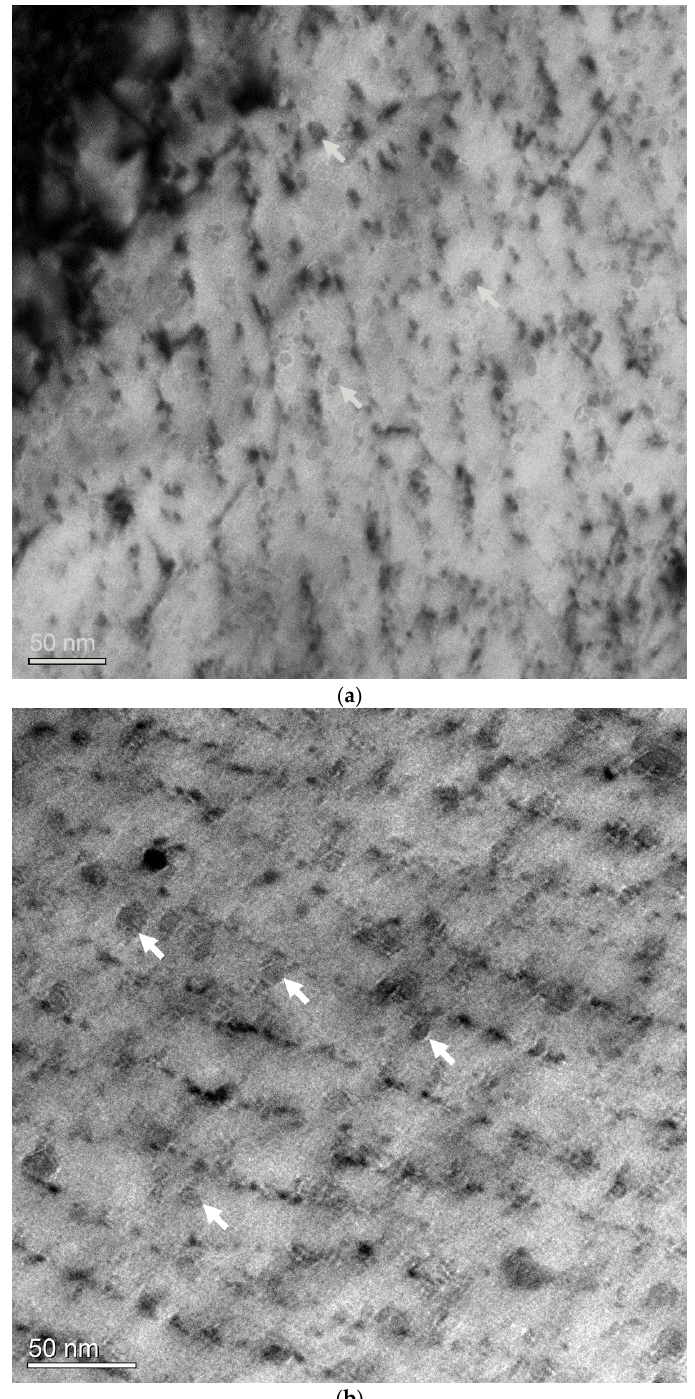
Figure 5. Bright-field TEM images showing nanometer-sized precipitates in samples after holding at 600 °C ( a ) and 650 °C ( b ) for 3 h, obtained by FEI Tecnai G20 TEM and FEI Tecnai F20 FE-TEM, respectively.